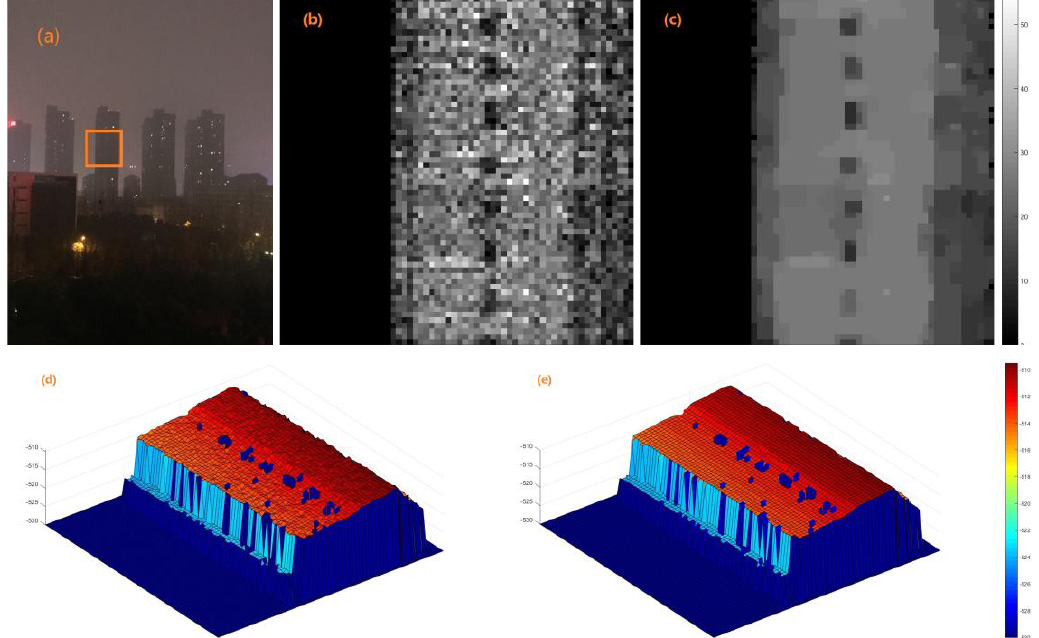
Figure 2 Photograph and photon-counting images of a building about six hundred meters away. (a) Building photograph. (b) Intensity image after noise censoring. (c) Intensity image reconstructed with regularization method. (d) Range image with maximum likelihood estimation. (e) Range image reconstructed with regularization